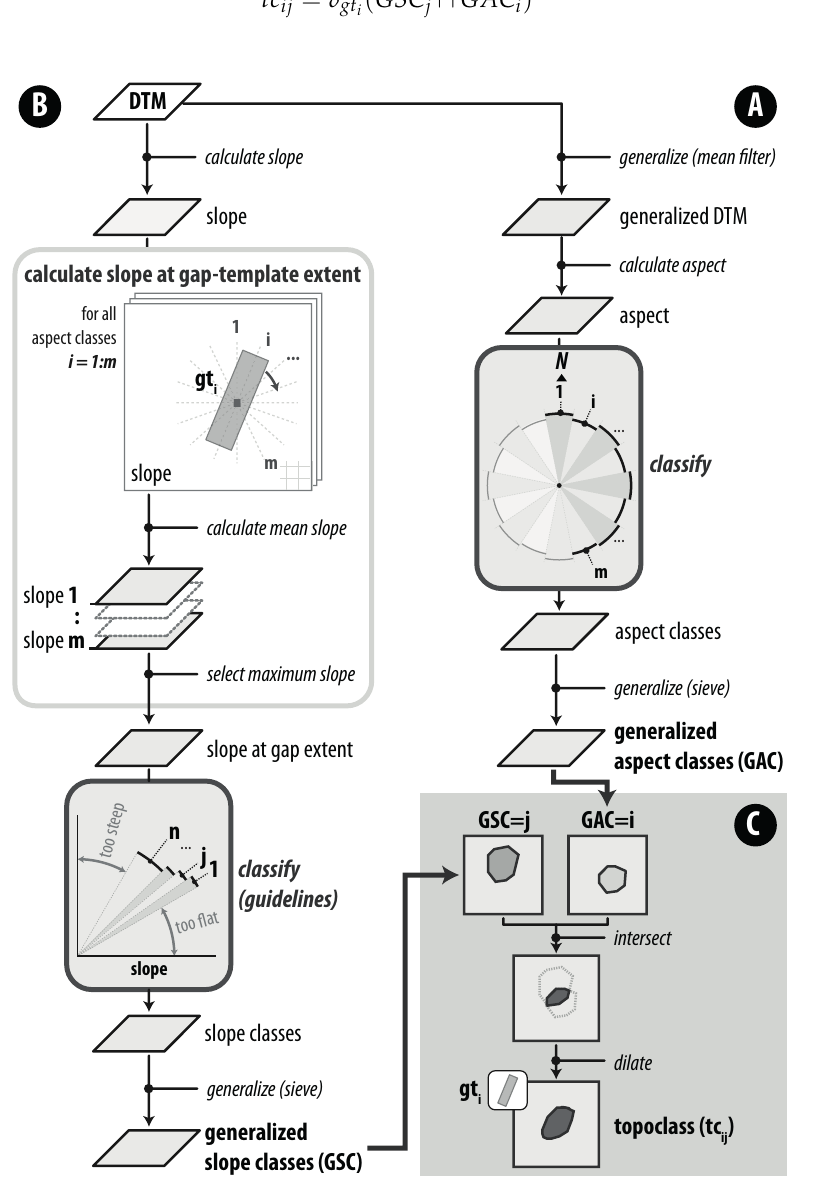
Figure 2. Workflow for the computation of topoclasses ( tc ij ) based on generalized slope- and aspect classes ( GSC , GAC ). Part (A) depicts the steps to calculate GACs , part (B) the ones to calculate GSCs . Part (C) explains the computation of overlapping topoclasses to overcome likely limitations resulting from artificial boundaries. Therefore, the intersections of GSC j and GAC i are morphologically dilated with the gap-template ( gt i ) corresponding to aspect class i